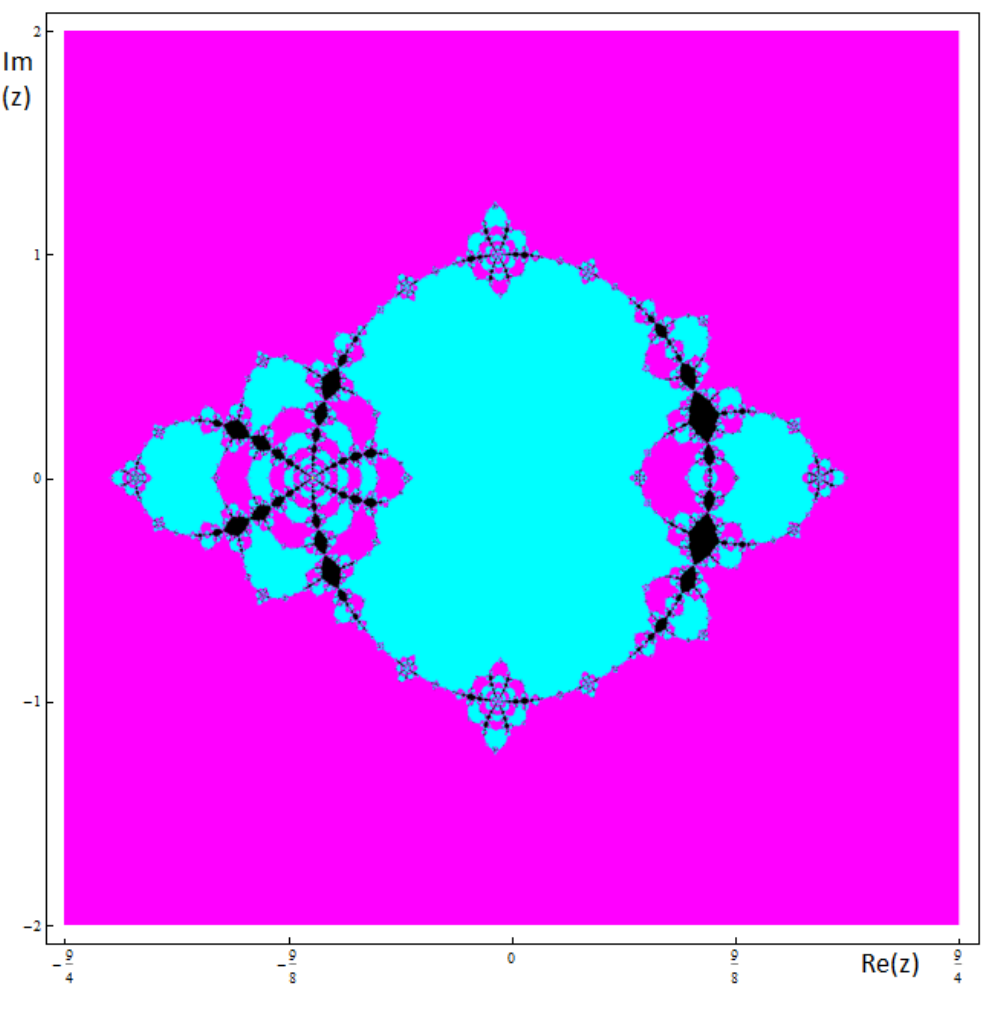
Figure 9. Basins of attraction associated to the member of the family a 0 = 3.6 and a 1 = − 4.75. The black zones are related to the convergence of a